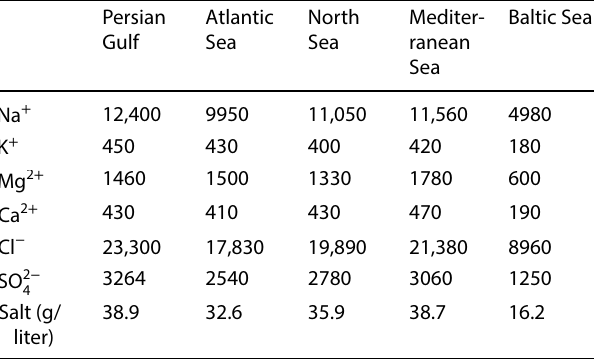
Table 1 Compositions of seawaters in the Persian Gulf and other regions [7, 8] Persian Atlantic North Gulf Sea